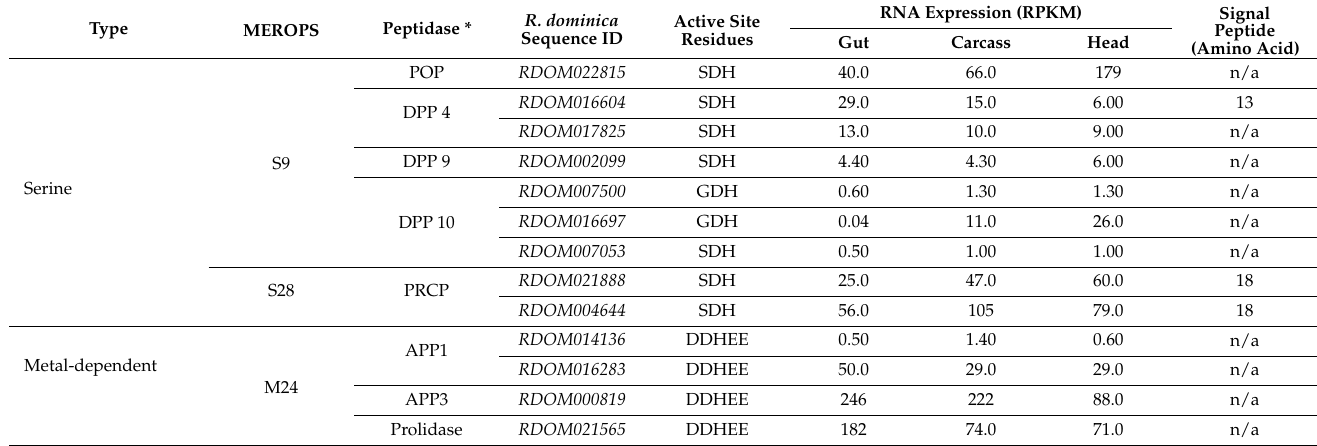
Table 3. General characteristics of R. dominica PSPs (active site residues, RNA expression and signal peptide